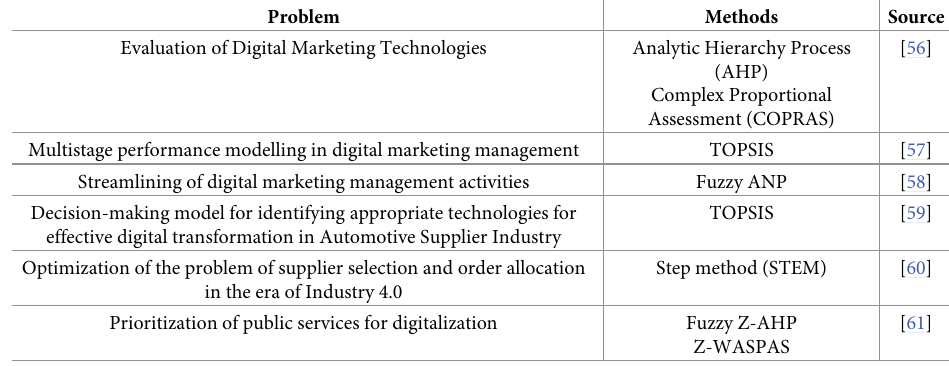
Table 3. Summary of applications of MCDM methods to solve different